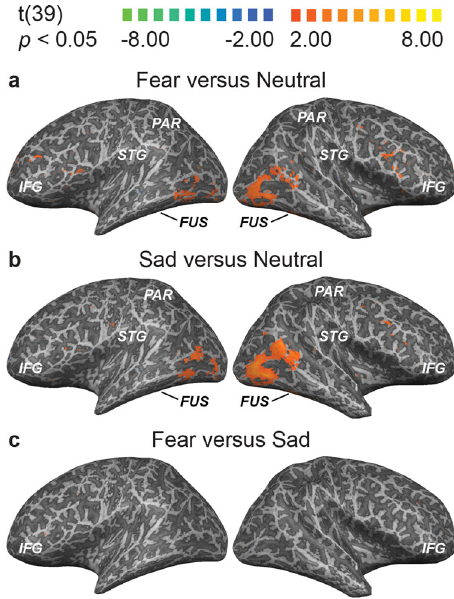
Fig. 2 Whole-brain GLM analyses comparing affective conditions. Results of contrasting responses: a fearful (fear – fear mask) and neutral stimuli (neutral – neutral mask), b sad (i.e., sadness – sadness mask) and neutral stimuli (neutral – neutral mask), and c fearful (fear – fear mask) and sad stimuli (sadness – sadness